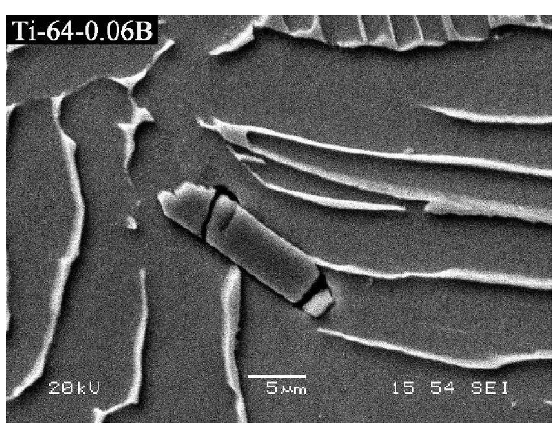
Figure 8. SEM image of the microstructure in a Ti-64-0.06B sample compression tested at 500°C with a strain rate of 0.001 s − 1 . Here a fractured TiB particle can be seen, forming cavities within the matrix